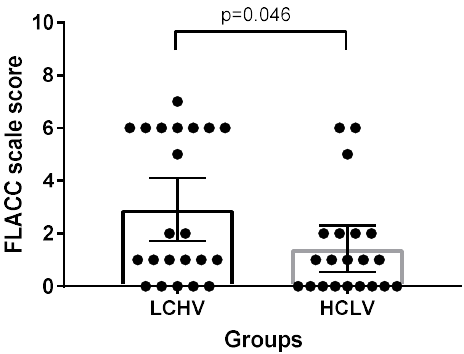
Figure 2. Face, leg, activity, cry, consolability scale score at post-anesthetic care unit. LCHV, Low- concentration high-volume; HCLV, high-concentration low-volume.